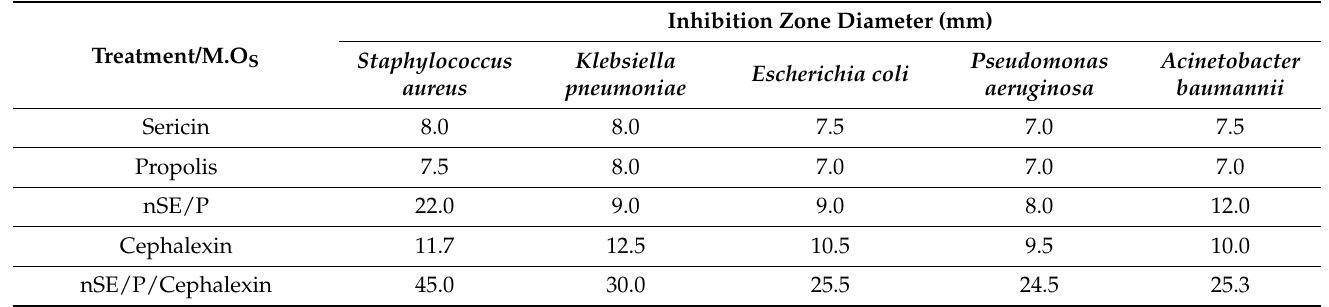
Table 5. The combined action between the tested antibiotics and the prepared